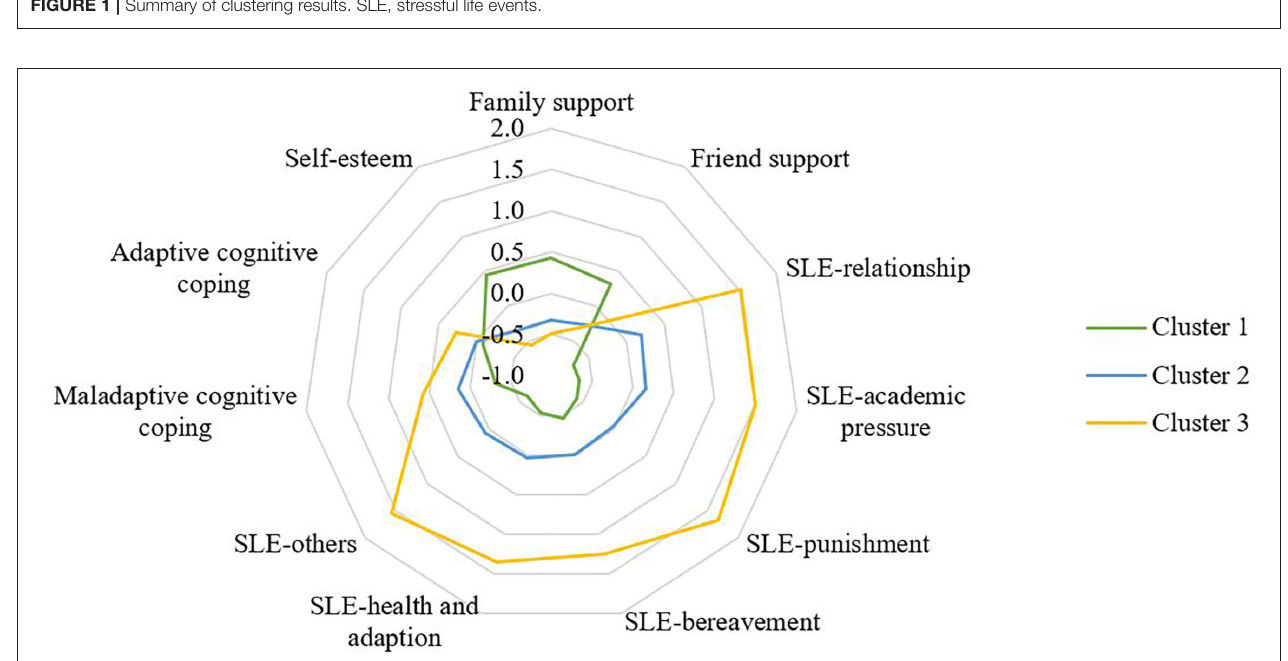
FIGURE 2 | Radar-chart displaying the differences between the three clusters. SLE, stressful life events. Standardized scale scores were presented.